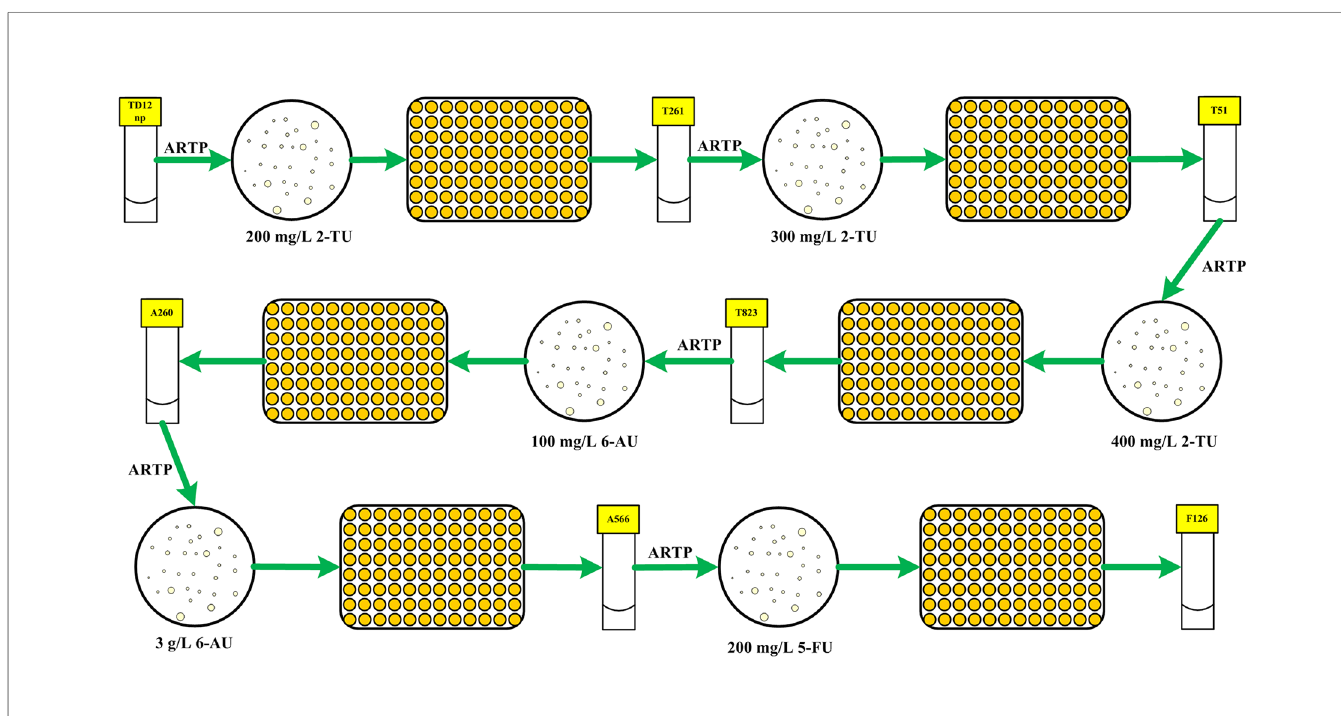
Fig 1. Procedure of high-throughput screening of B . subtilis mutants generated by ARTP. 2-TU represents 2-thiouracil;6-AU represents 6-azauracil; 5-FU represents 5-fluorouracil.